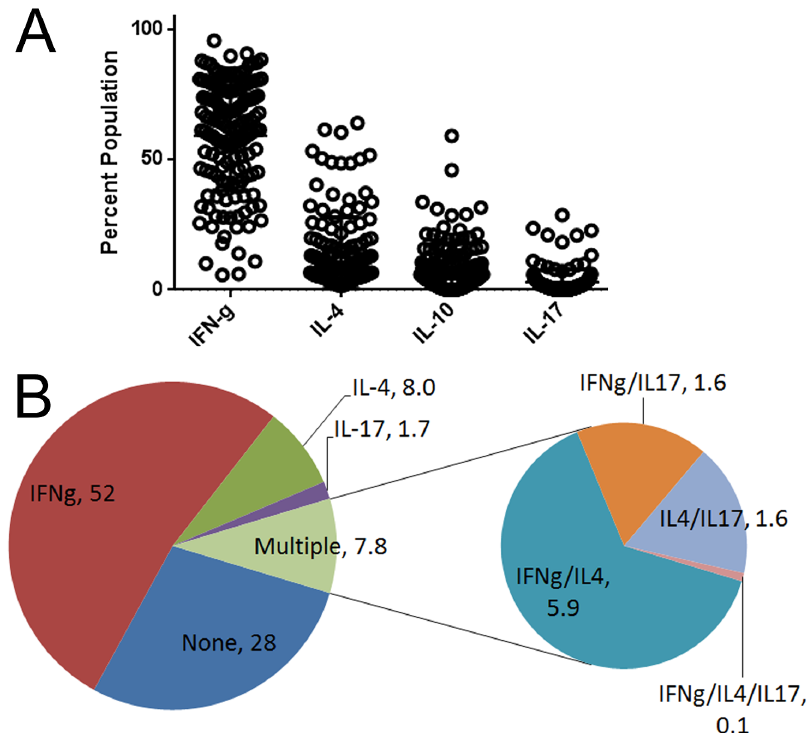
Fig 2. Cytokine profiles of WNV-specific T cells A) WNV-specific T cell lines specific for single epitopes were isolated from WNV infected subjects and analyzed for IFN- γ , IL-4, IL-10, and IL-17 content by intracellular cytokine staining. Each symbol indicates the percentage tetramer positive T cells that were cytokine positive within a single cell line. B) Averaging across all subjects tested, the large pie charts depicts the proportion of WNV specific T cells in subjects with WNV infections that stained positive for IFN- γ only, IL-4 only, IL-10 only and IL-17 only, or any combination of these cytokines ('multiple'). Within the 7.8% of T cells that produced multiple cytokines, the small pie charts indicate the proportion of cells that stained positive for IFN- γ and IL-4; IFN- γ and IL-17; IL-4 and IL-17; or IFN- γ , IL-4, and IL-17. For all other possible combinations the percentage observed was negligible. These data were obtained from a total of 144 WNV specific lines isolated from 16 different subjects.